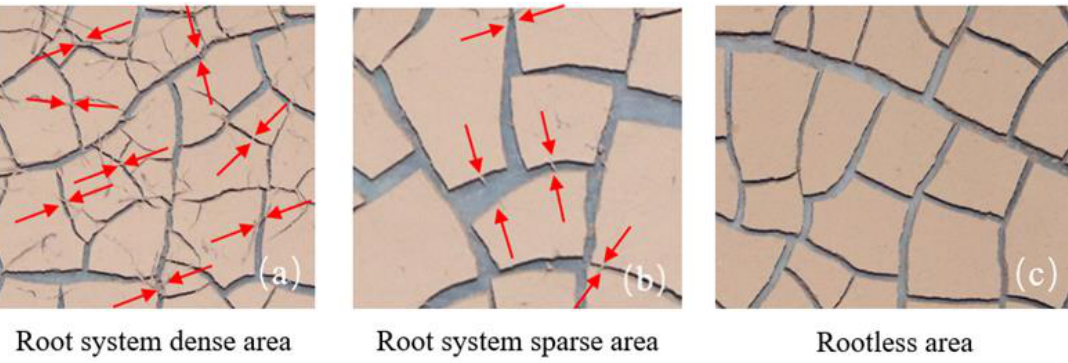
Figure 7. Distribution characteristics of setaria viridis root